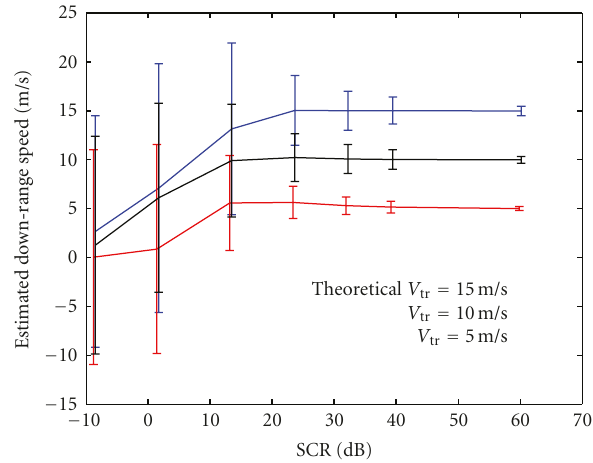
Figure 7: The target’s estimated range speeds as a function of signal-to-clutter ratio. Standard deviations of the estimates are shown as error bars. Three target velocities are simulated: ( V tr , V ta ) = (5, − 10),(10, − 10),(15, − 10)